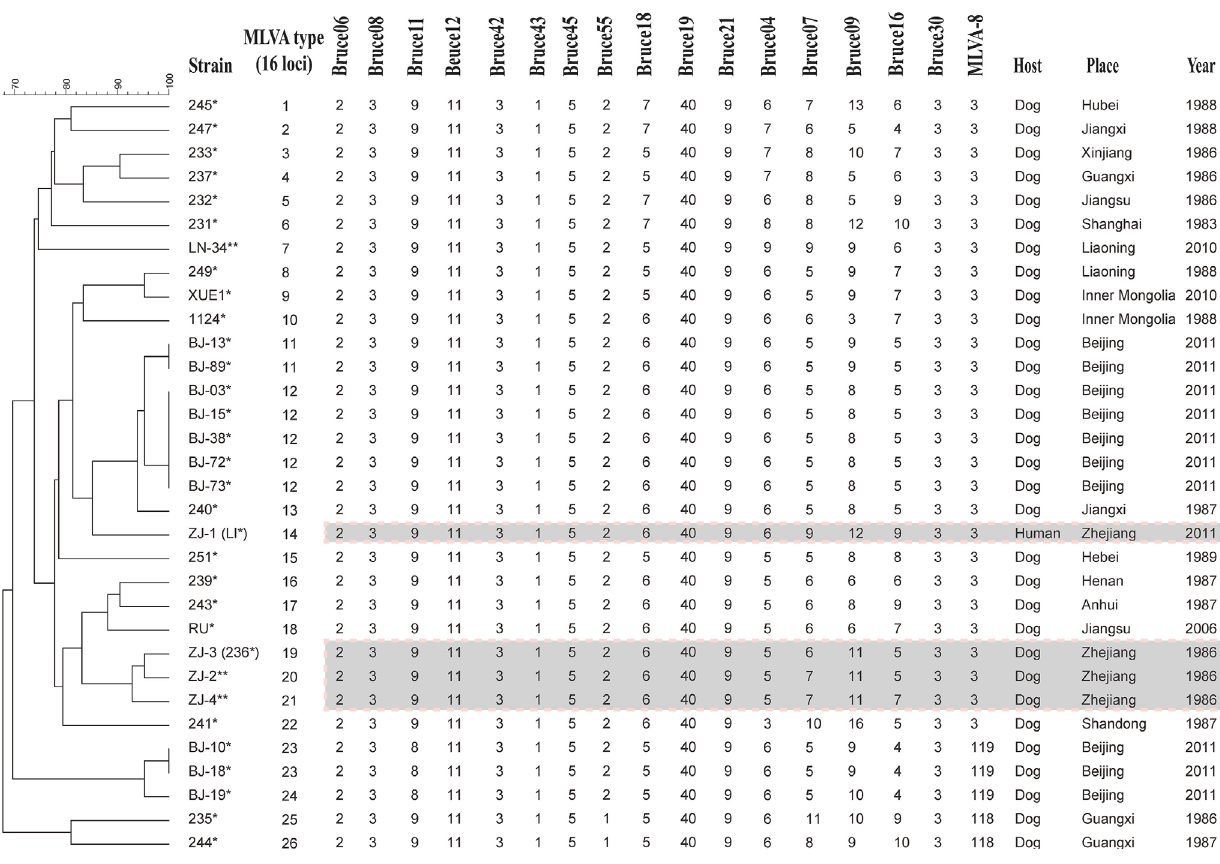
FigUre 2 | Dendrogram based on the MLVA-16 genotyping assay showing relationships of the four Brucella canis isolates from Hangzhou in this study to other B. canis strains. Strain: strain name in the laboratory in which the DNA extraction was done; year/place: year and country of isolation (when known); * indicates these strains were previously analyzed in Di et al. (23). ** indicates these strains have been analyzed in this